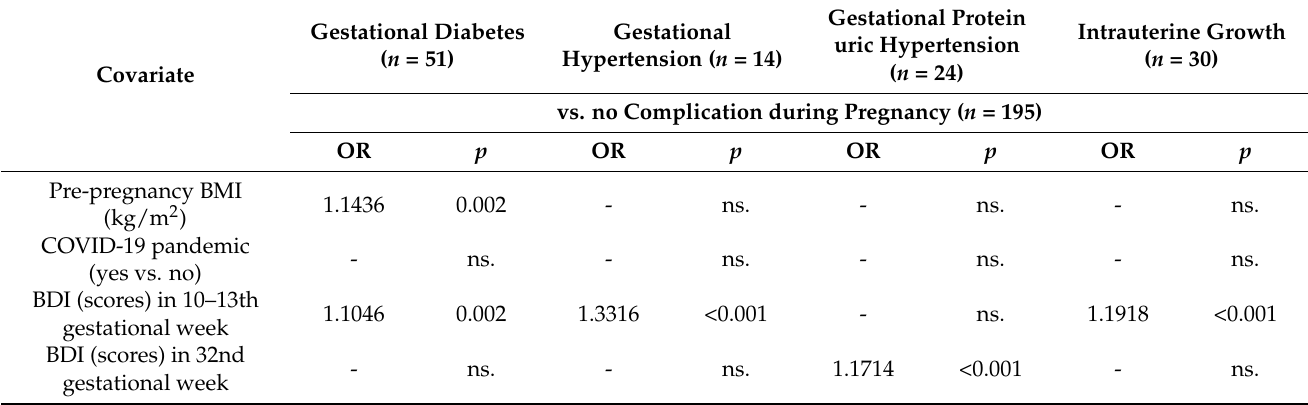
Table 6. Multivariate logistic regression models of pregnancy complication against pre-pregnancy BMI, COVID-19 pandemic, and severity of